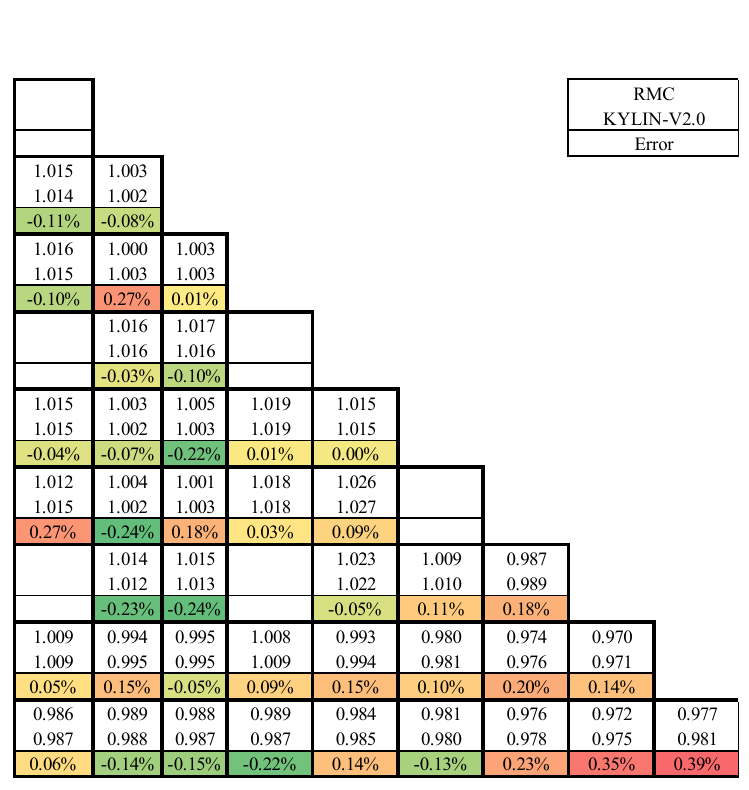
Figure 11. VERA 2B fuel assembly pin power distribution at 60 GWd/tU